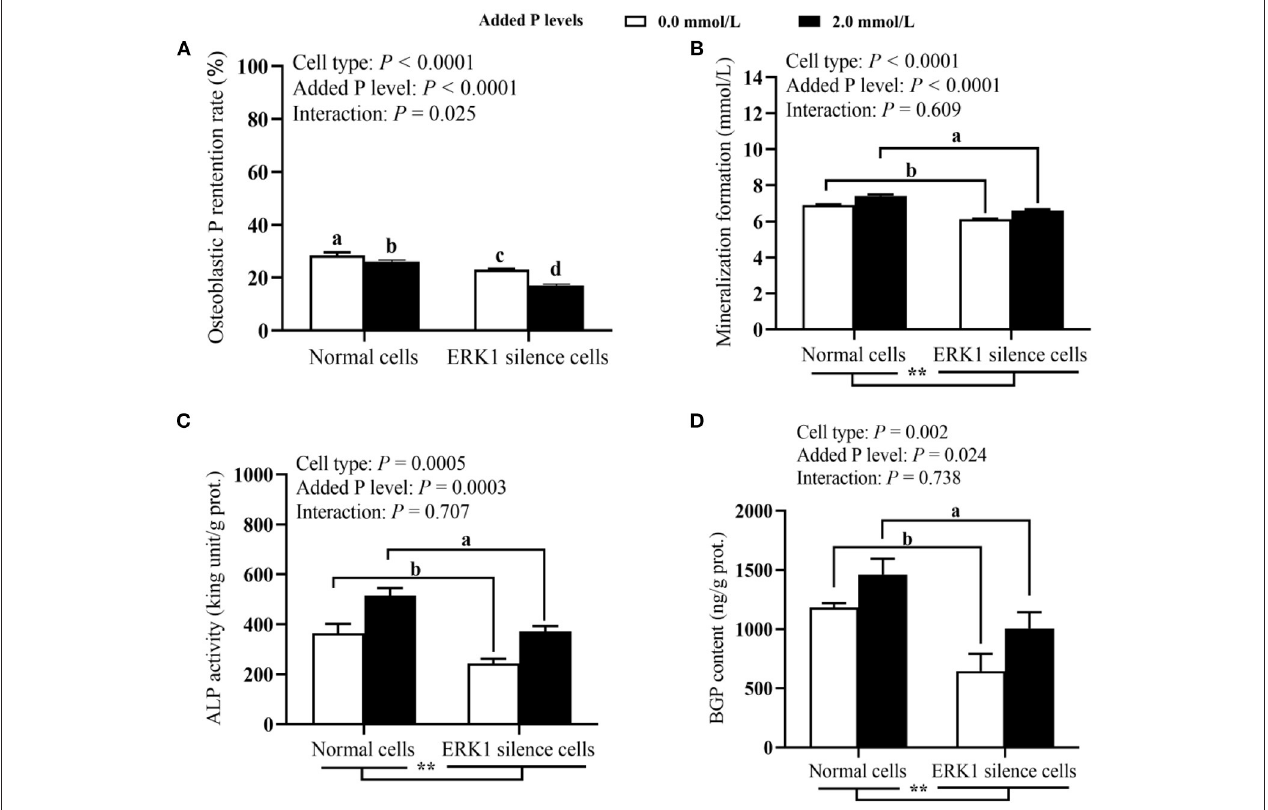
FIGURE 4 | Effects of cell types and P levels on the P retention rate (A) , mineralization formation (B) ALP activity (C) , and BGP content (D) in primary broiler osteoblasts (experiment 2). Each value represents the means ± SE, n = 4. Lacking the same letters (a, b, c, d) means significant differences, P < 0.05. ** P < 0.01. ALP, alkaline phosphatase; BGP, bone gla protein; ERK, extracellular signal-regulated kinase 1; P,